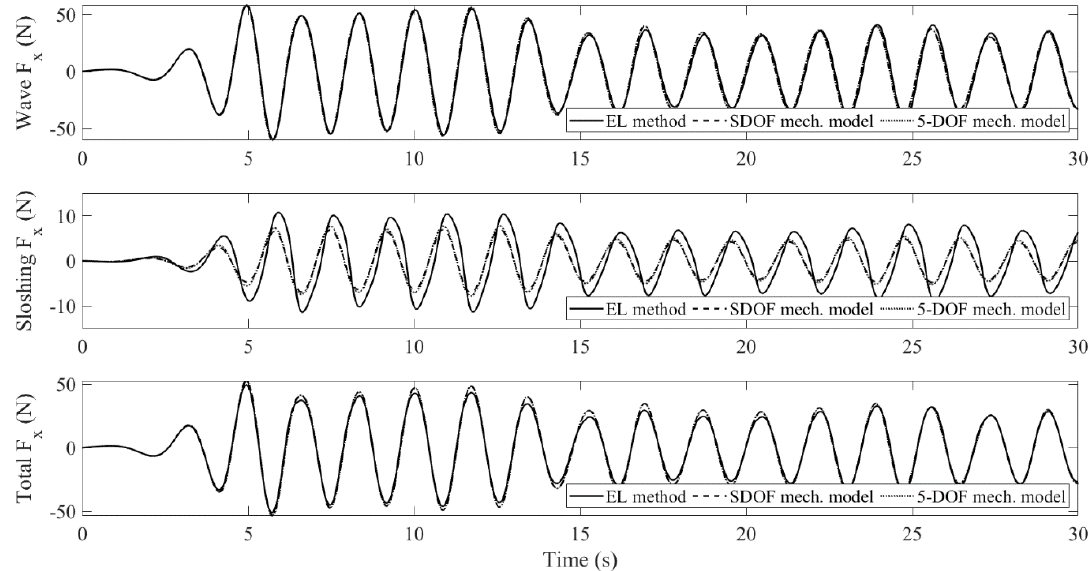
Figure 9. The horizontal forces acting on the floating body for the large-wave case.